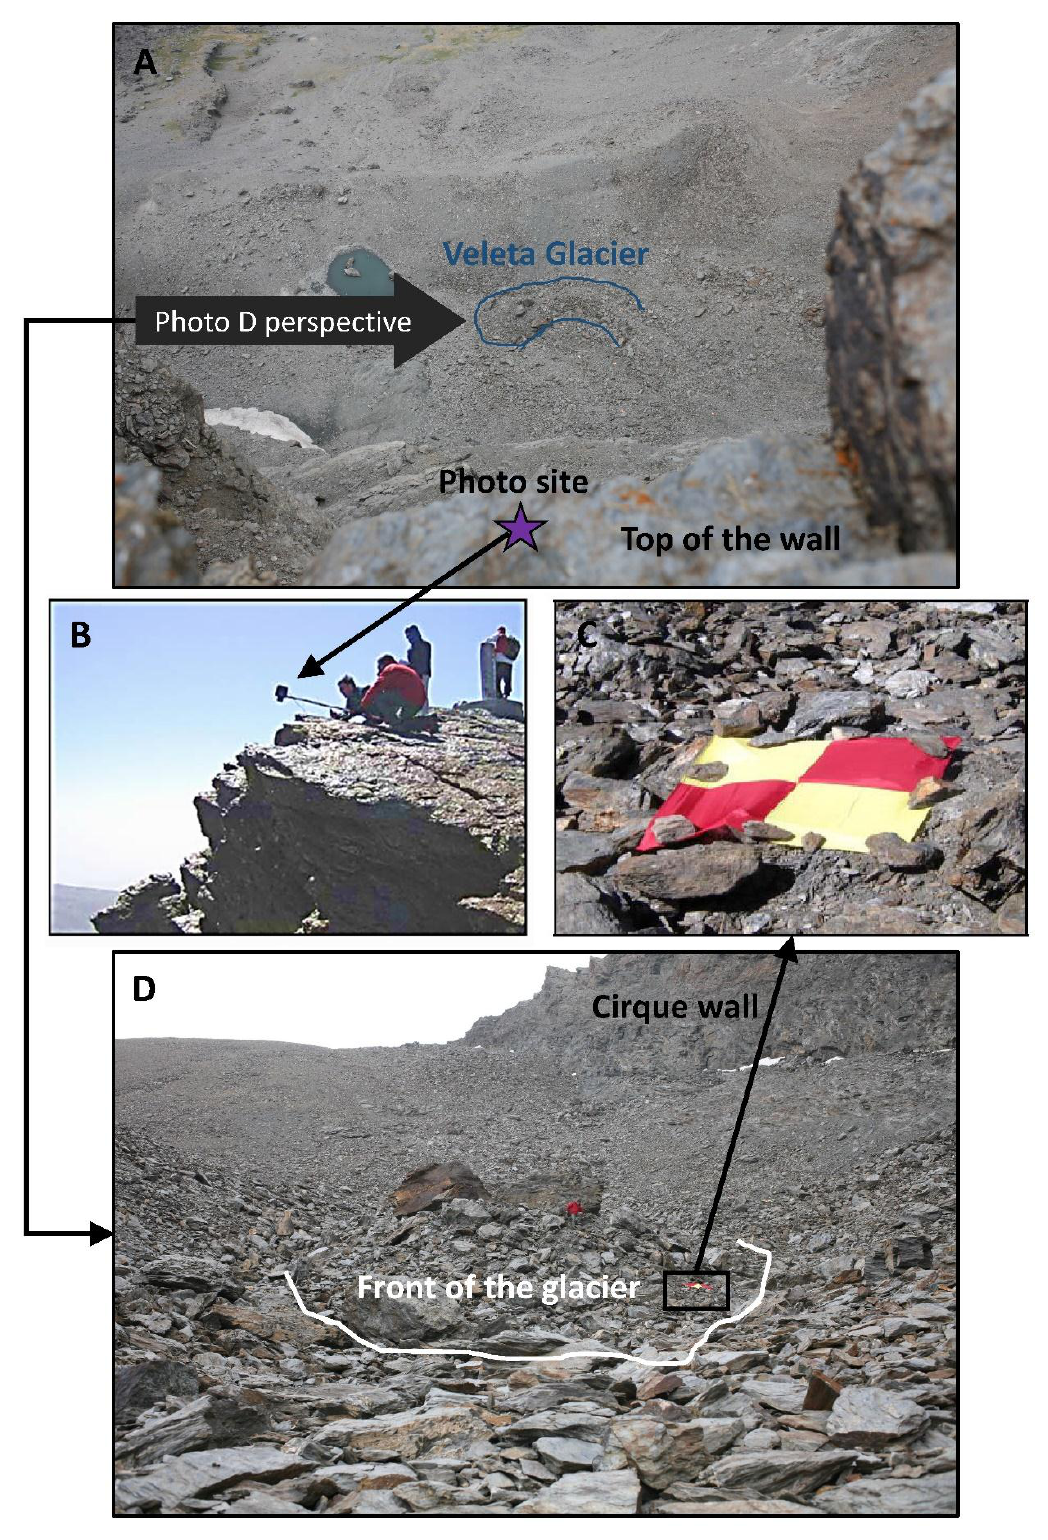
Figure 2. ( A ) View of the glacier from the top of the Corral del Veleta wall, ( B ) detail of the capture where the constrains for camera locations can be observed, ( C ) detail of a control point and ( D ) oblique photograph showing the front of the glacier and the steep relief and rough topography in the surroundings. Note that it is not possible to capture an oblique photograph of the whole glacier in the